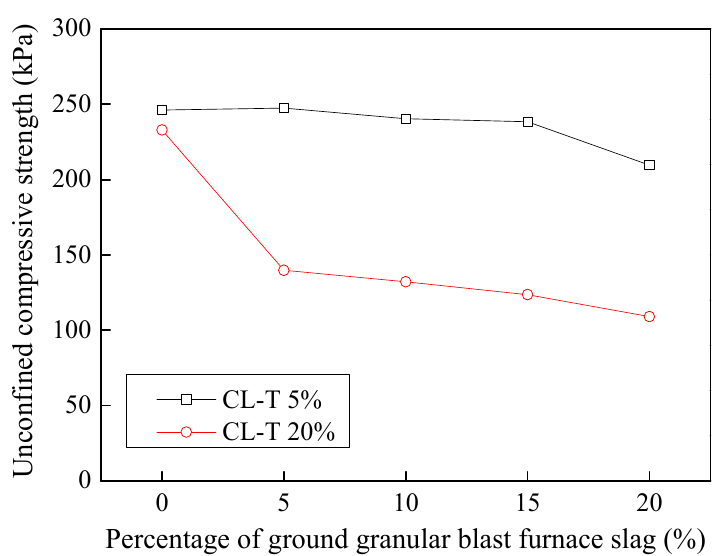
Figure 20. Improvement of tannery effluent contaminated CL soil using GGBFS. Processes 2018 , 6 , x FOR PEER REVIEW